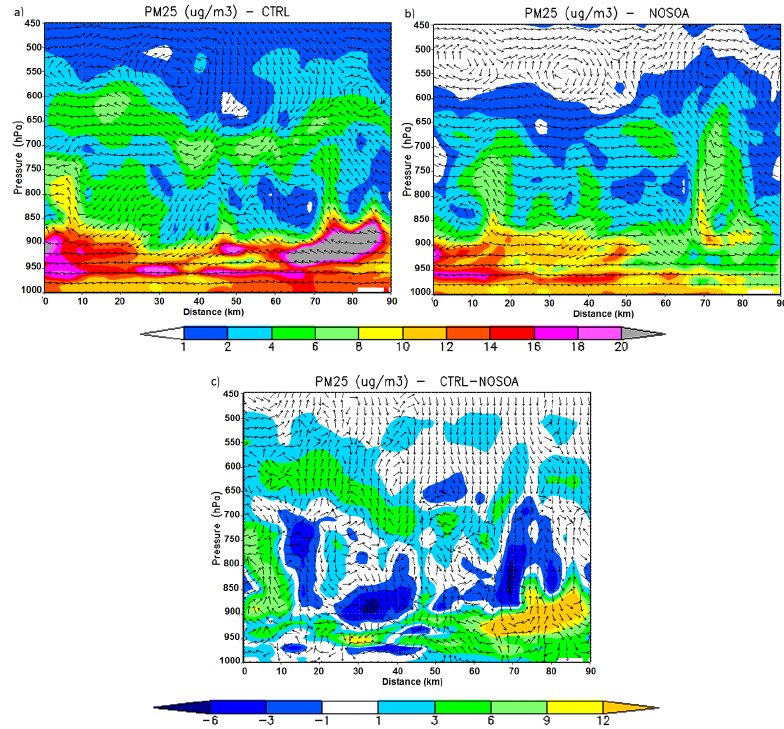
Figure 16. Vertical profile of PM 2 . 5 mass (colour) and wind (vector) for CTRL run (a) , NOSOA run (b) , and their differences (c) . The fields are extracted along the cross section A (see Fig. 12) at 06:00UTC of 17 May. The x axis reports the west–east distance in kilometres along the cross